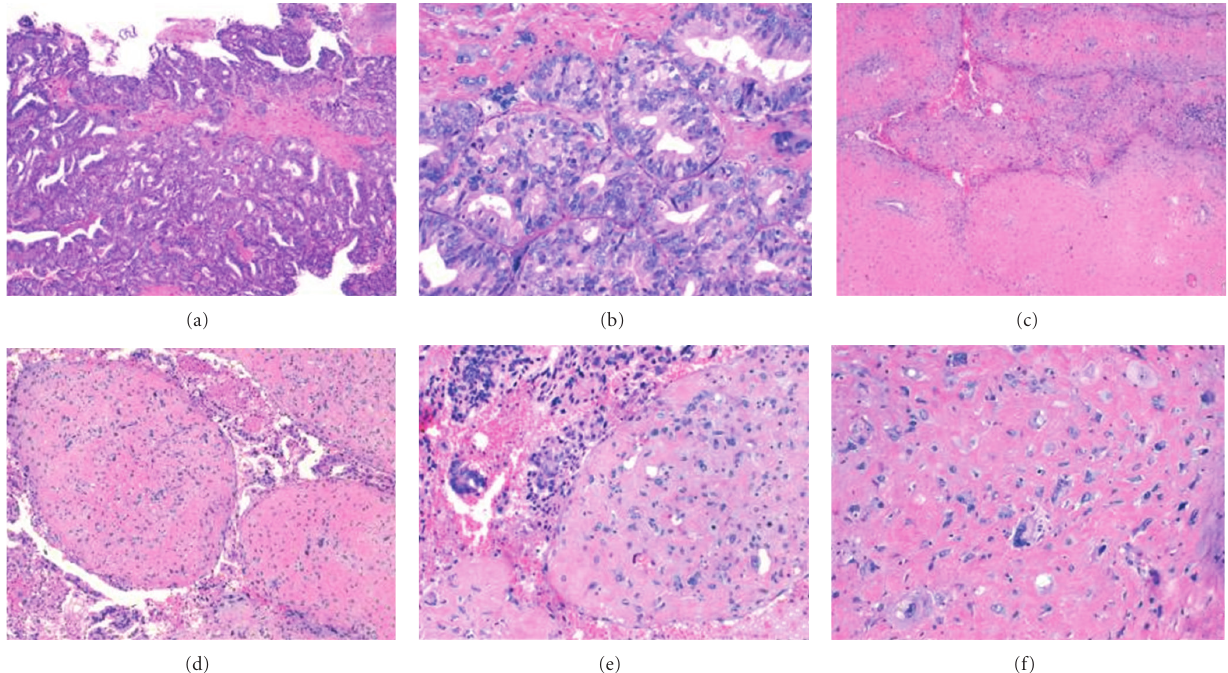
Figure 2: Microscopic finding. (a) Typical histopathologic aspect of prostatic ductal adenocarcinoma, showing a cribiform pattern. (b) Stroma with giant cells. (H-E, 50x–100x). (c, d, and e) Pleomorphic sarcoma characterized to have overall glandular growth pattern (H-E, 50x-100x-200x). (f) Malignant stroma showed increased cellularity and pleomorphism. Note: no spindled, fascicular, or heterologous growth pattern were presents. (H-E, 400x).